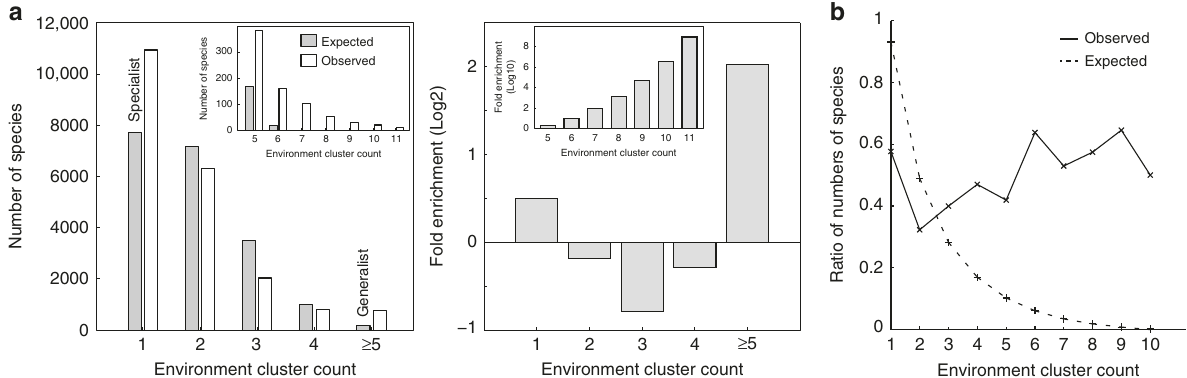
Fig. 2 Classi fi cation of generalists and specialists. a The distribution of the number of environment clusters that a species belongs to was compared to the expected distribution derived from 100,000 permutations. The insets show the detailed histograms for species that belong to fi ve or more environment clusters. b The rate of new habitat acquisition (the y -axis, “ Ratio of Number of Species ” ), as represented by ratio of the number of species that belong to N + 1 environment clusters over the number of species that belong to N clusters, are higher than expected, especially for classi fi ed generalists (species that belong to at least fi ve environment clusters). The x -axis indicates the number of clusters,